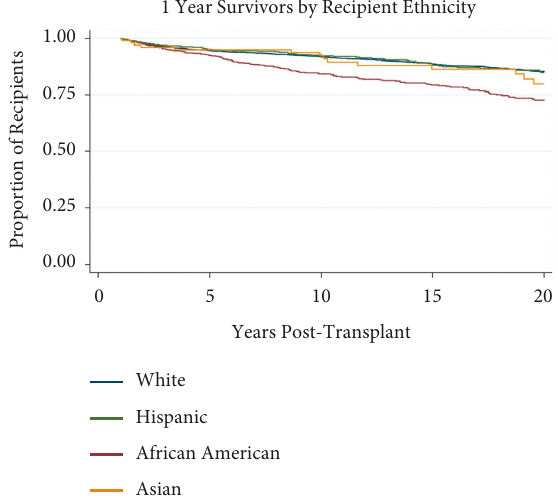
Figure 5: Kaplan–Meier survival function over time for 1-year survivor pediatric liver transplant recipients by recipient